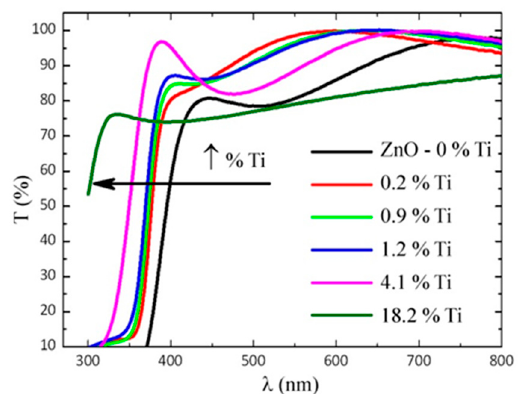
Figure 6. The optical transmittance spectra of TZO samples with different Ti contents, including the ZnO reference film: The arrow indicates the direction in which the optical absorption edge shifts when the Ti content increases.